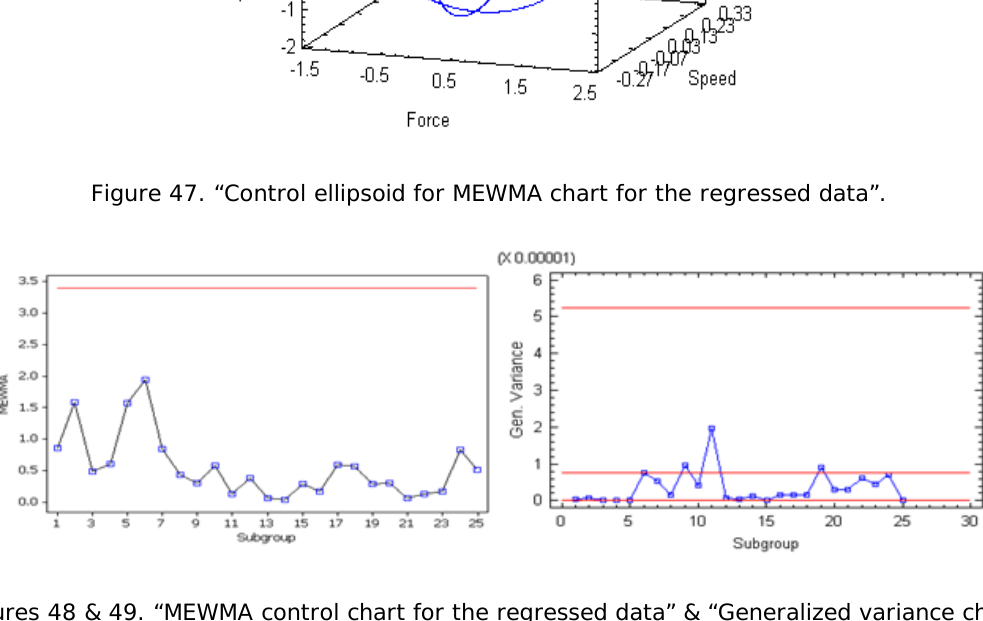
Figures 48 & 49. “MEWMA control chart for the regressed data” & “Generalized variance chart for the regressed